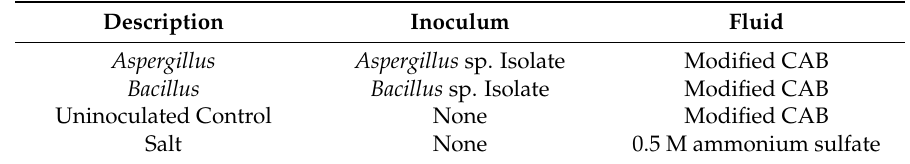
Table 1. Set up of batch leaching tests.